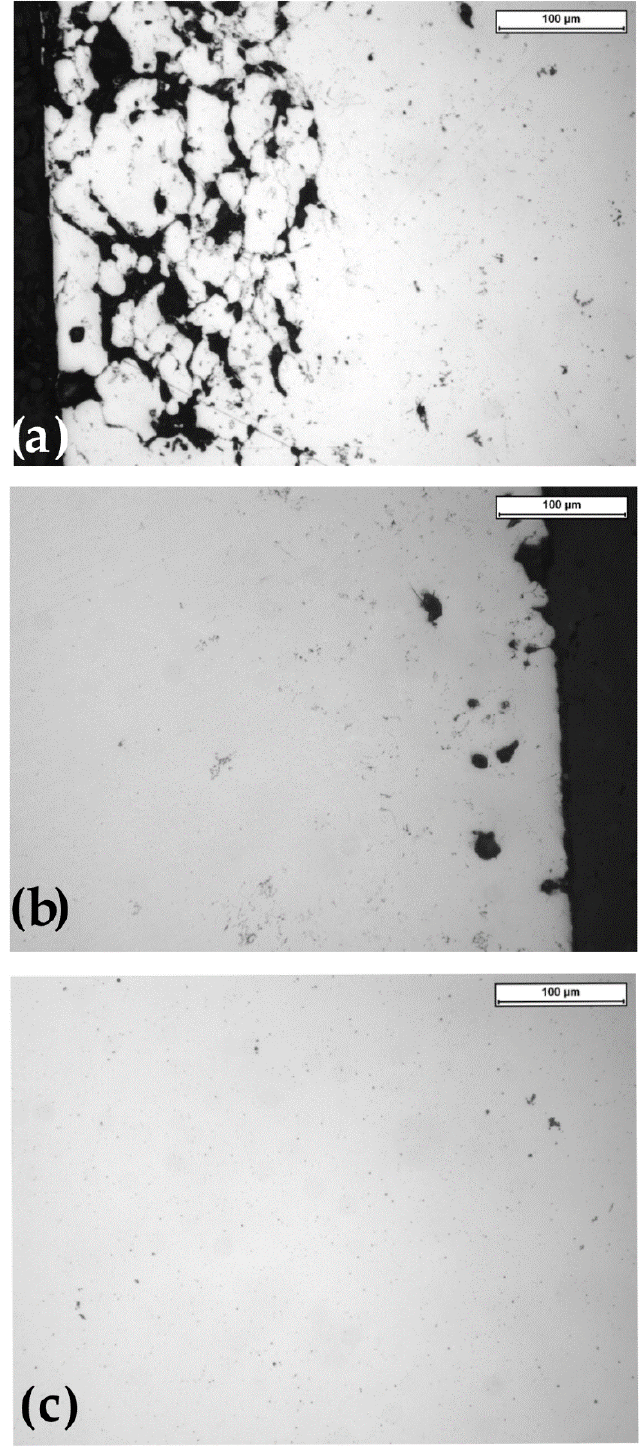
Figure 3. Optical micrograph of samples obtained through ESF. ( a ) Edge of sample E (YZ—plane), ( b ) edge of sample B (YZ—plane), and ( c ) core of sample F.